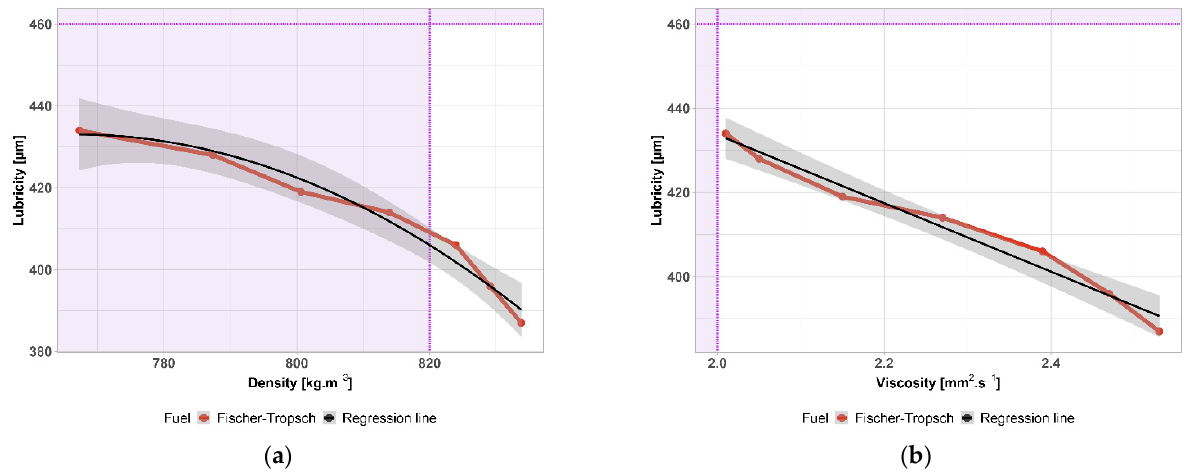
Figure 9. ( a ) Regression function of lubricity as a function of density; ( b ) regression function of lubricity as a function of viscosity. Table 4. Parameters of the regression equation 𝑊𝑆𝐷 = 𝐴 + 𝐵𝑥 + 𝐶𝑥 (cid:2870) depicted in Figure 6. Correla- tion coefficients, R adj2 , and p-value for both physical properties.